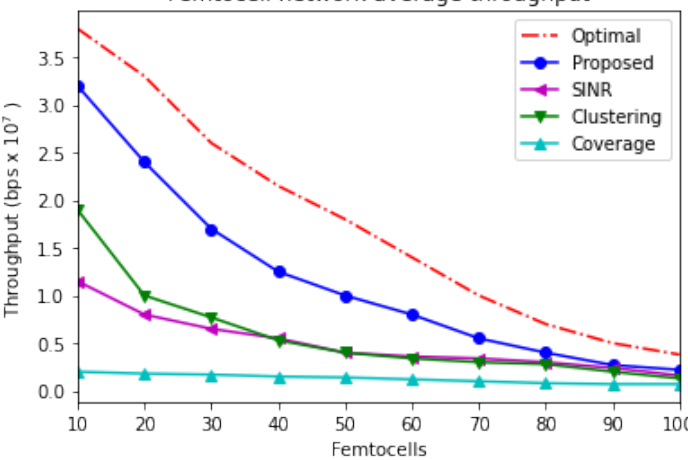
Figure 5. Femtocell network average throughput with interference consideration.